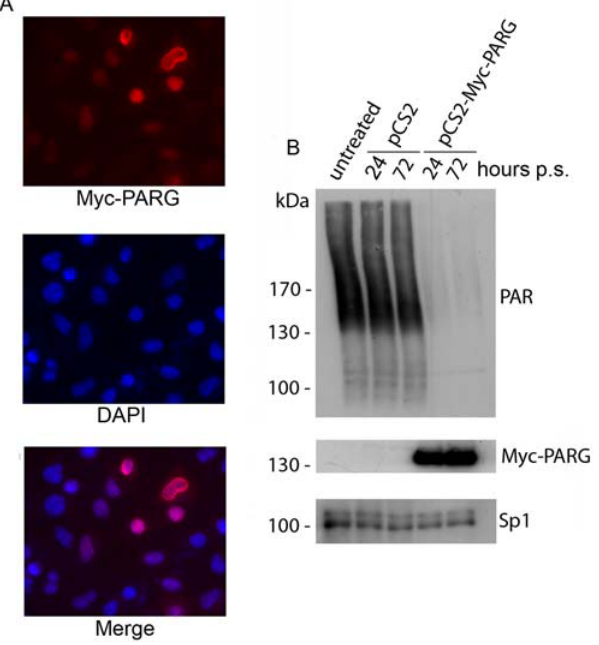
Figure 1. Ectopic over-expression of PARG. A, Immunofluores- cence images showing the nuclear localization of ectopically over- expressed PARG. B, Western blot of proteins from cell cultures at 24 and 72 hours of puromycin selection (p.s.) transfected with pCS2-Myc-PARG vector 24 hours before selection vs control cells. Analyses were performed using anti-PAR antibodies, anti-Myc epitope antibody for Myc-PARG; anti-Sp1 antibody was used as endogenous control. pCS2: empty vector; pCS2-Myc-PARG: vector containing full length cDNA for human PARG.